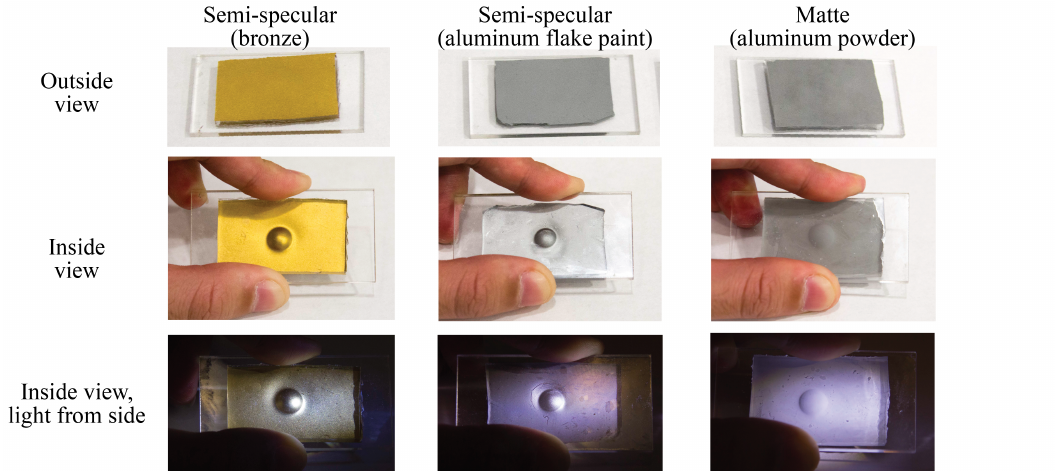
Figure 4. Three kinds of elastomer coatings: semi-specular coating painted by bronze flake and aluminum flake paint, and matte coating by aluminum powder. In the second and third row, the three pieces of elastomer are pressed against a ball with diameter of 6 mm, but the in the 3rd row, the elastomer is illuminated by light from side